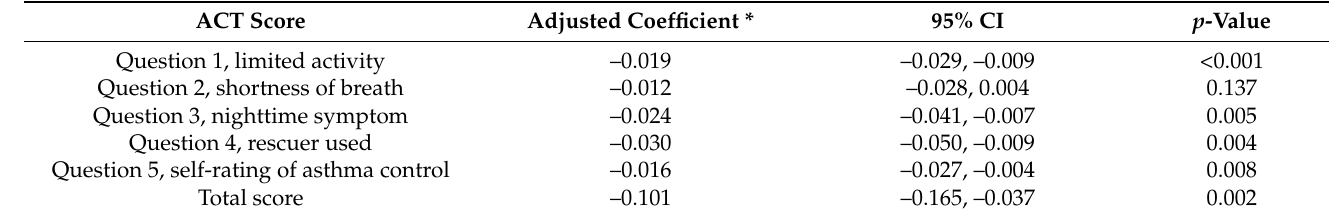
Figure 1. Variation of Monthly Average PM 10 and Monthly Average of ACT Scores Throughout the Study Period. (Abbreviations: ACT, Asthma Control Test; PM10, particulate matters with diameter less than 10 microns). Table 5. Associations between Every 10 µg/m 3 Increase in Monthly Average of PM 10 and Monthly Average of Total Asthma Control Test (ACT) Score and Sub-domains.